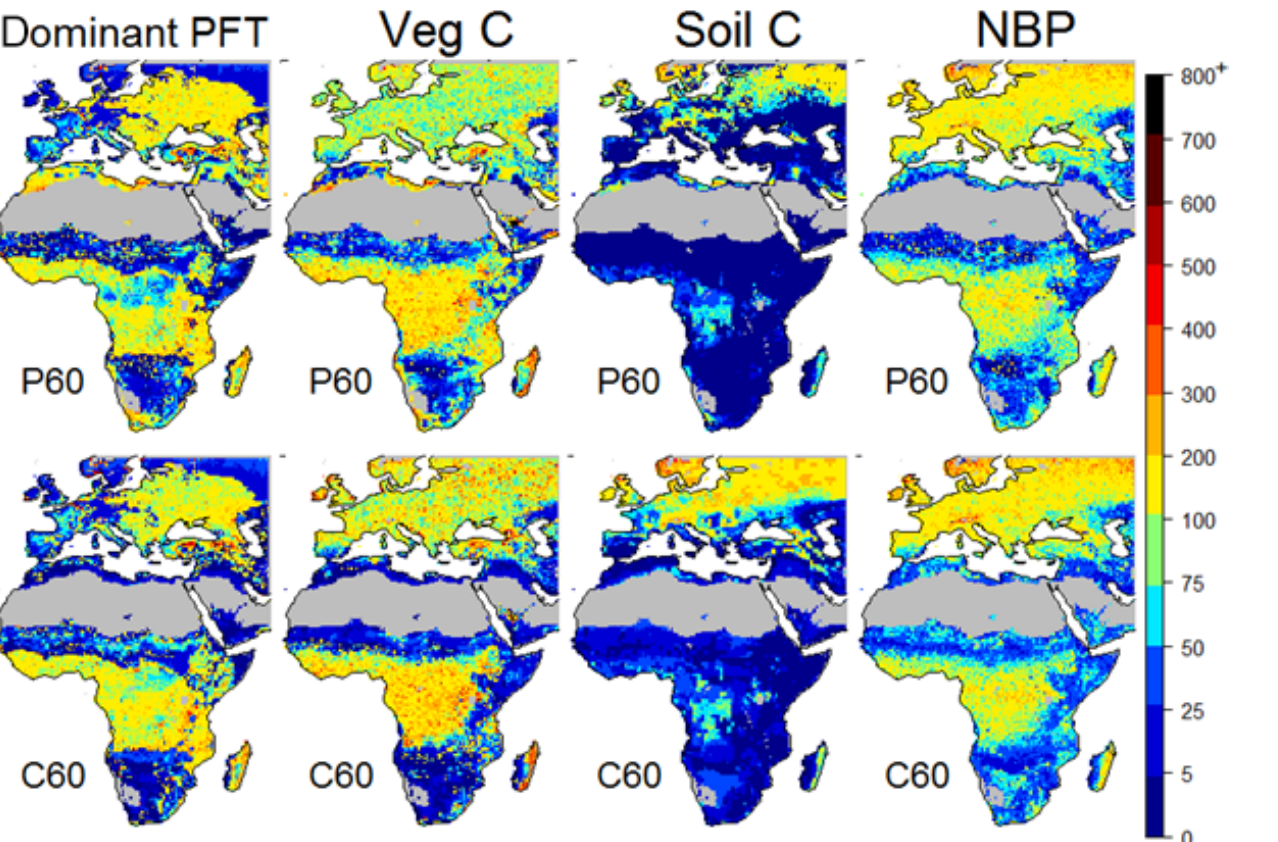
Figure A4. Maps of recovery time for the dominant PFT, vegetation C, soil C and NBP with an alternative recovery definition for the P60 and C60 simulations. The definition is the same as our standard definition but with a mean · 0.95 threshold instead of mean − 1 σ